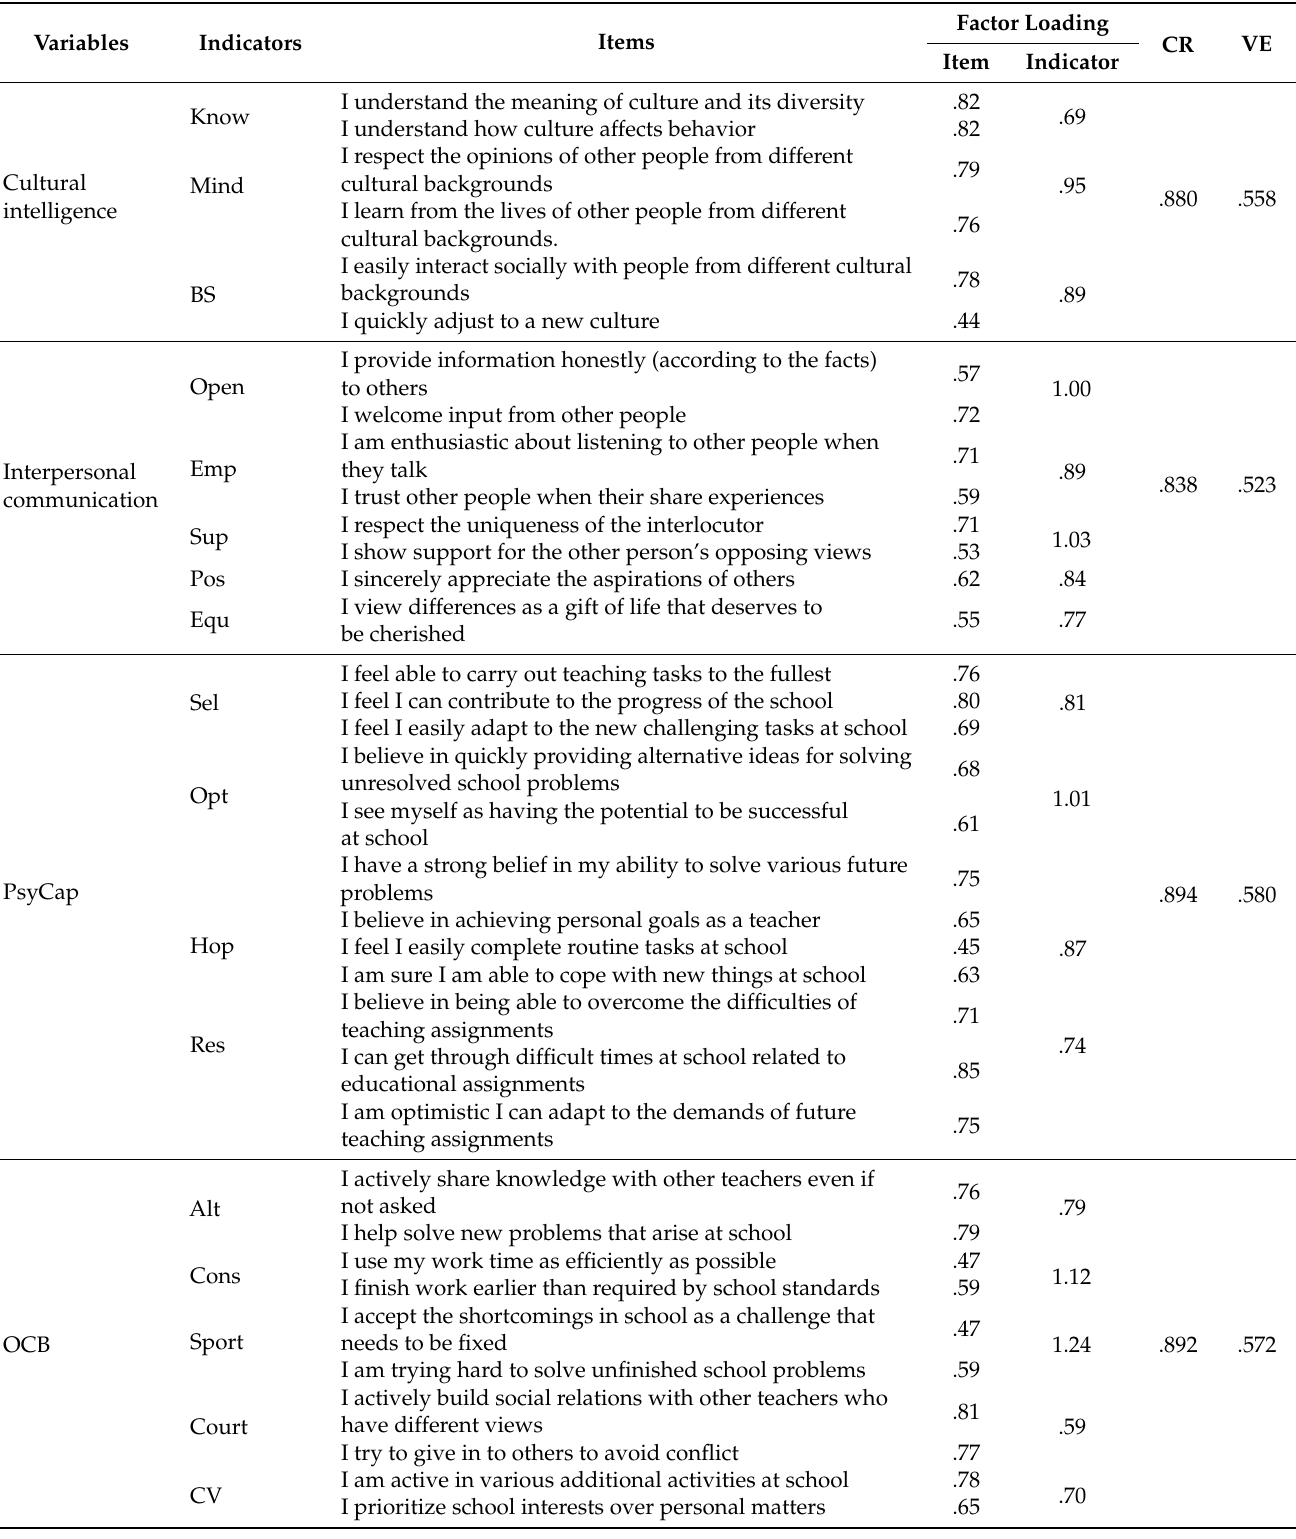
Table 3. Results of the measurement